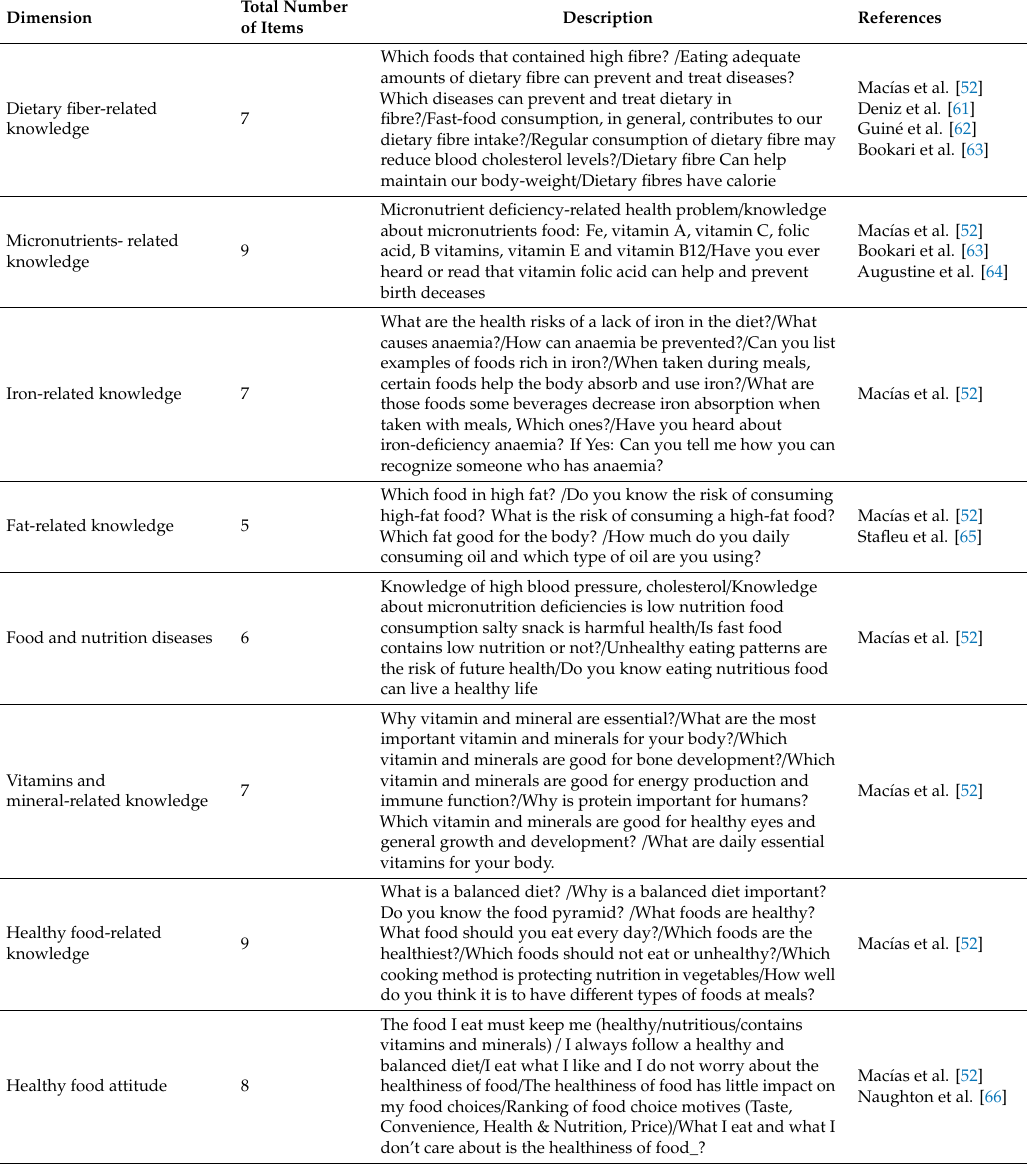
Table 1. The study questions of food and nutrition-related knowledge and